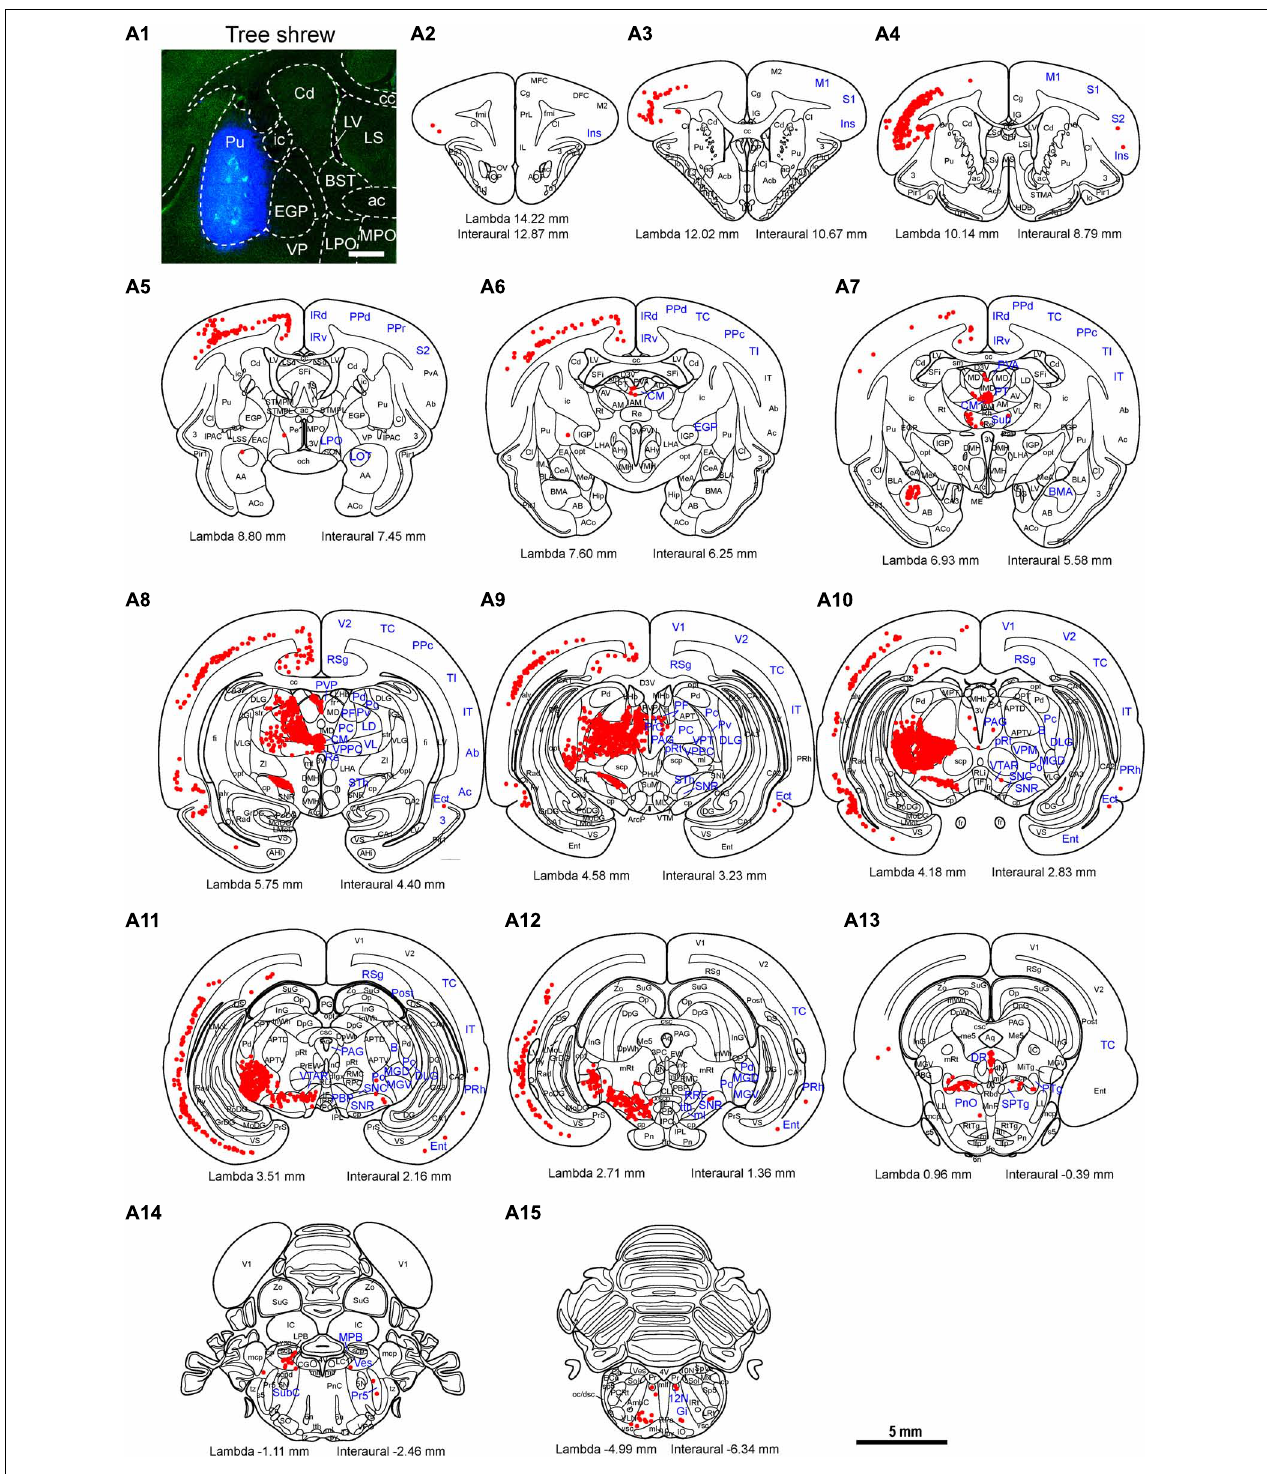
FIGURE 7 | Whole-brain mapping of afferent projections to the putamen (Pu) in tree shrews. (A1) Unilateral pressure injection of FG retrograde tracer (blue) into the Pu of the tree shrew brain. The Pu was determined by staining with NeuroTraceTM 500/525-Green Fluorescent Nissl Stain (green). (A2–A15) Camera lucida drawings showing the distribution of Pu-projecting neurons (red dots) in the tree shrew brain (blue letters). Representative coronal sections from rostral to caudal were selected from two tree shrew brains and referenced to lambda (distance indicated at lower left corner). The density of dots represents the relative density of projecting neurons in those areas. Each dot represents approximately one FG-labeled neuron. For abbreviations, see Abbreviations. Scale bars = 1 mm in (A1) ; 5 mm in (A2–A15) .